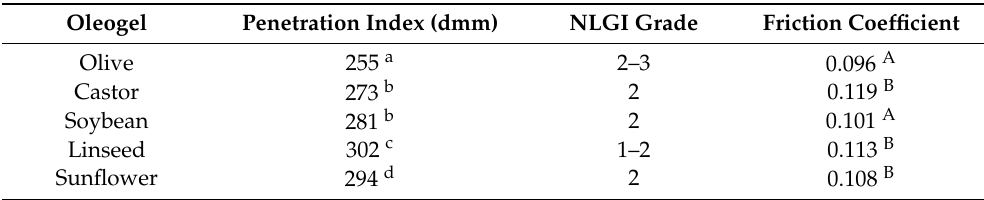
Table 3. NLGI consistency numbers, penetration and friction coefficient values for oleogels studied. Oleogel Penetration Index (dmm) NLGI Grade Friction Coefficient Olive 255 a 2–3 0.096 A Castor 273 b 2 0.119 B Soybean 281 b 2 0.101 A Linseed 302 c 1–2 0.113